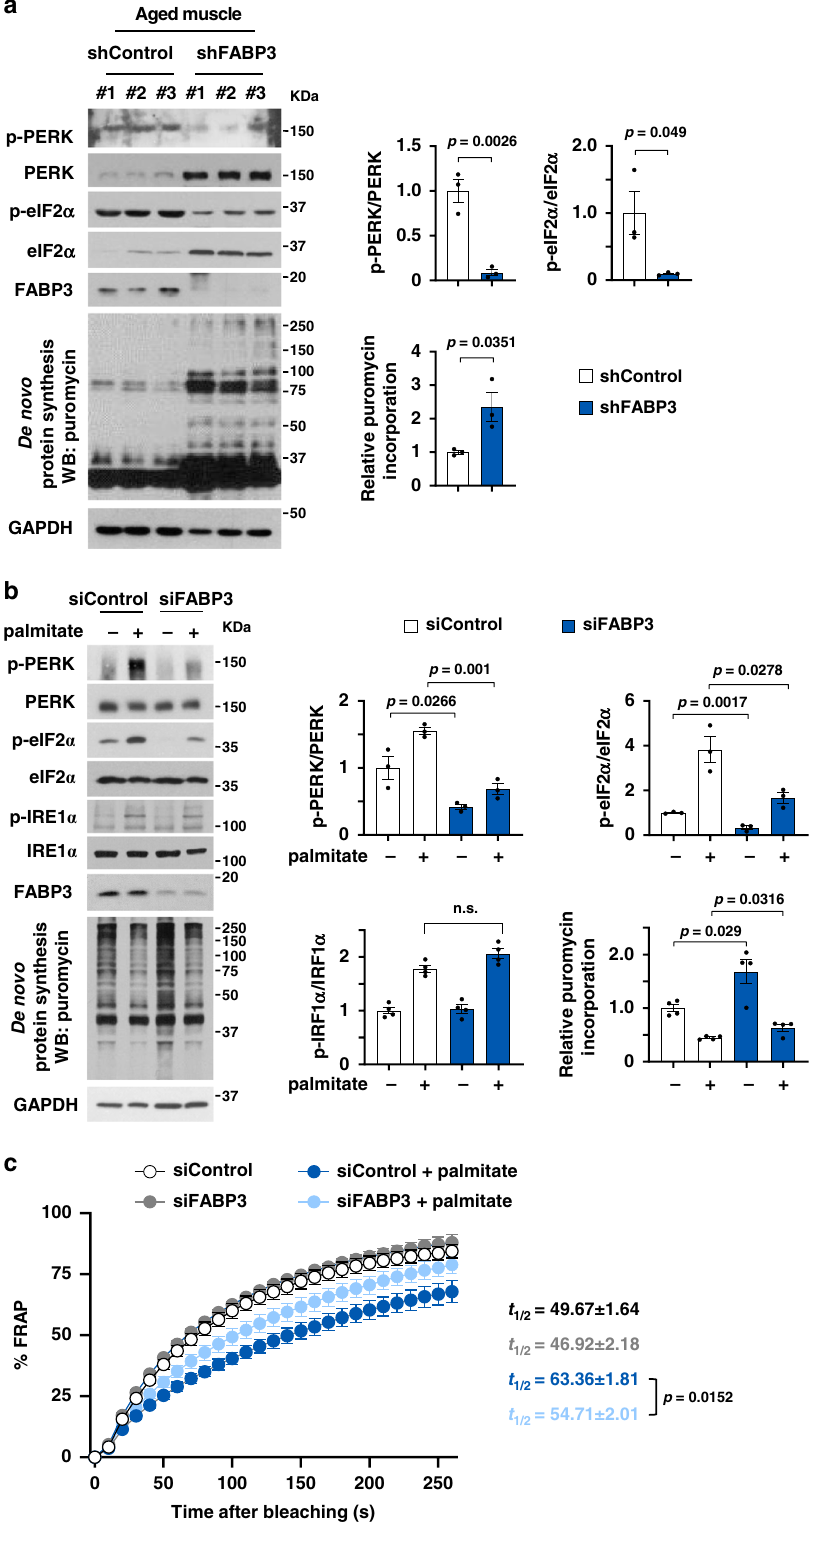
Fig. 6 FABP3 inhibition alleviated ER stress. a , b Immunoblot analysis (left) and quanti fi cation (right) of the indicated proteins and puromycin incorporation in FABP3-knockdown aged and control muscles ( a ) and FABP3-knockdown myotubes ( b ). GAPDH was used as a loading control. TA muscles of aged mice ( a ) were infected with Ad-shFABP3 virus or Ad-shControl. Mice were injected intraperitoneally with puromycin (0.04 mmol/kg) 5 days after infection ( n = 3 mice per group). C2C12 myotubes ( b , c ) were transfected with siFABP3 or siControl and treated with palmitate (500 μ M) or vehicle for 12 h. Myotubes were then incubated with puromycin (1 μ M) for 30 min ( n = 3 independent experiments) ( b ). c Time course fl uorescence recovery. Note the t 1/2 values in FRAP analyses. Black, siControl, n = 6; gray, siFABP3, n = 6; deep blue, siControl + palmitate, n = 6; light blue, siFABP3 + palmitate, n = 7 each myotube. Data are presented as means ± S.E.M. Two-tailed unpaired Student ’ s t -test was used. Source data are provided as a Source Data fi